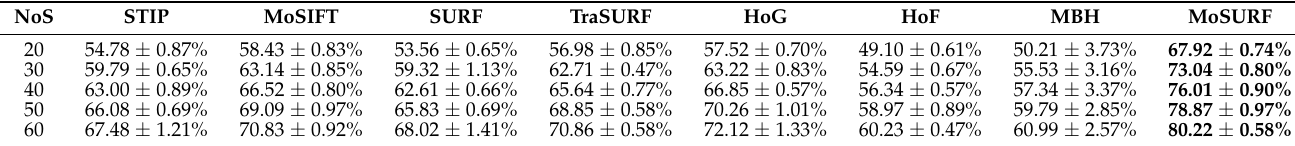
Table 3. Experimental results for different descriptors on